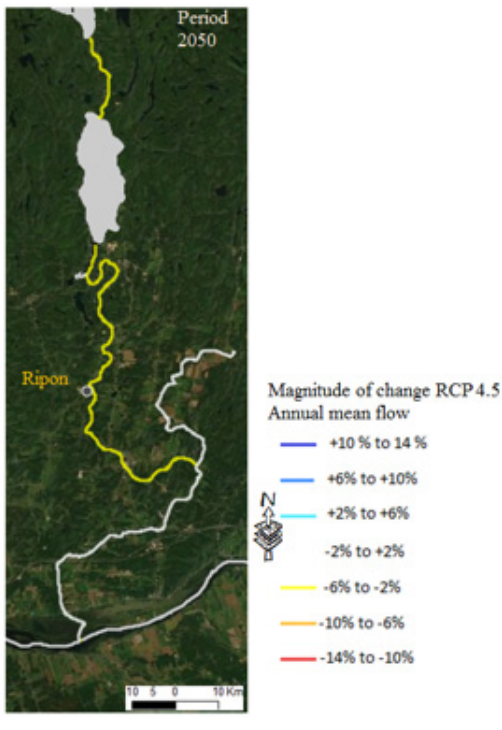
Figure 4. Hydroclimatic Atlas of Southern Québec average annual flow indicator, the magnitude of change RCP 4.5.